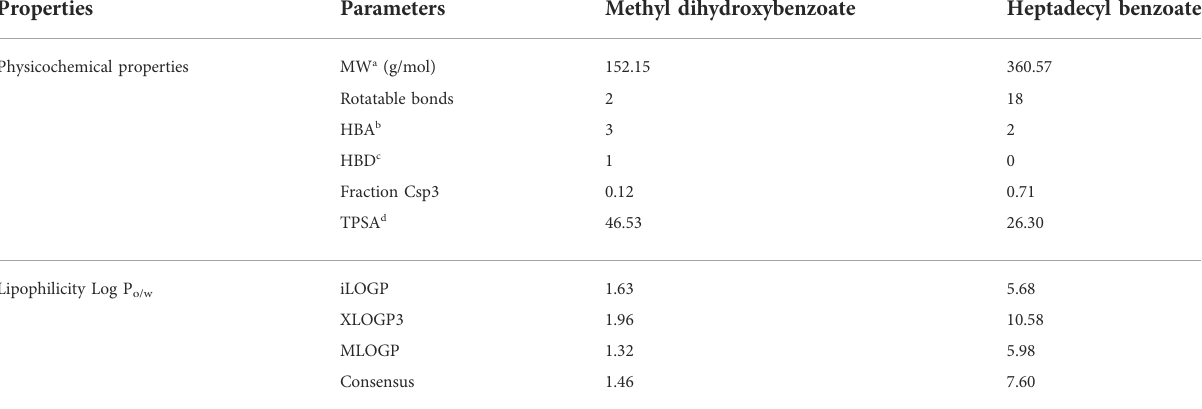
TABLE 2 Physicochemical and lipophilicity properties of methyl dihydroxybenzoate and heptadecyl benzoate. Properties Parameters Physicochemical properties